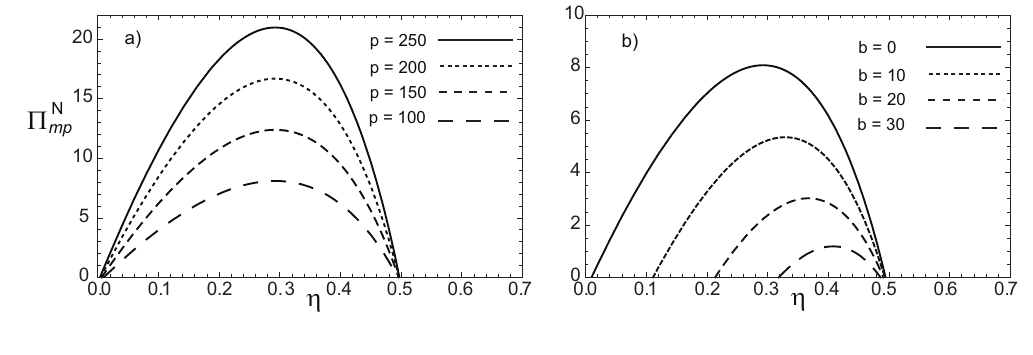
Figure 3. Profits function (cid:5) N in terms of the engine’s efficiency η with a Newton heat mp transfer law for a) b = 0 and taking several values of p and b) p = 100 and taking several values of b .